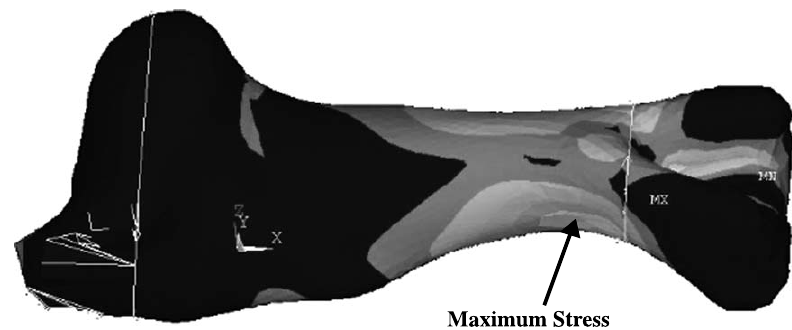
Fig. 7. Stress distribution in basic bending